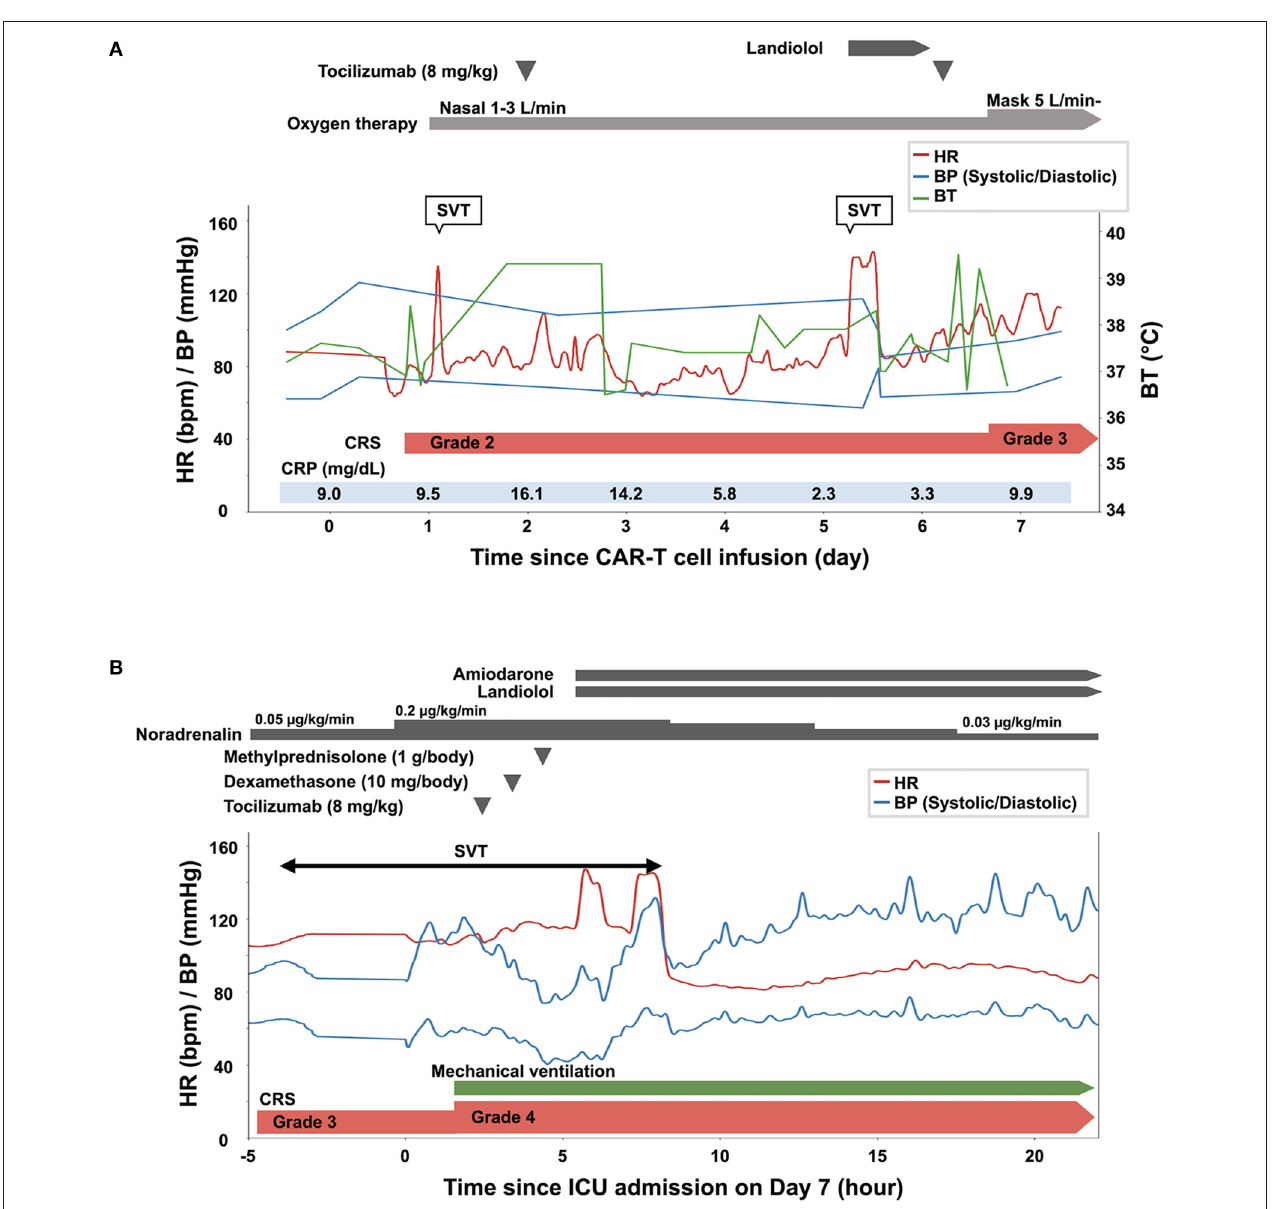
FIGURE 3 | Clinical course of the patient from the day of the infusion of chimeric antigen receptor T (CAR-T) cells (day 0) until day 6 (A) , and on day 7 (B) . BP, blood pressure; BT, body temperature; CRP, C-reactive protein; CRS, cytokine release syndrome; ICU, intensive care unit; SVT, supraventricular